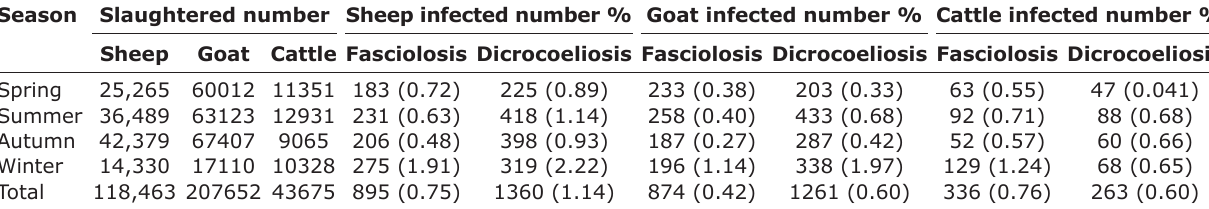
Table-2: Seasonal prevalence of liver condemnation resulting from Fasciola hepatica, Fasciola gigantica , and Dicrocoelium dendriticum in sheep, goats, and cattle at abattoirs of Arak, Iran.